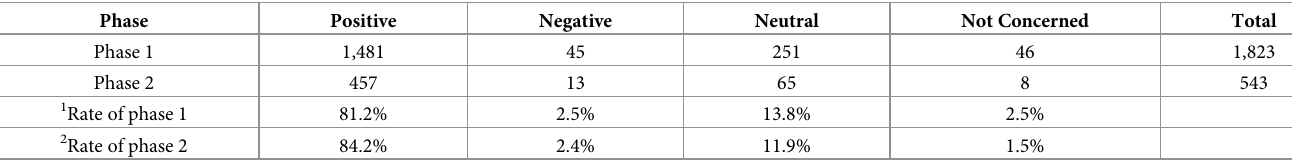
Fig 10. The total number of parameters and average of parameters for each influencer in two phases of the campaign. https://doi.org/10.1371/journal.pone.0274596.g010 Table 6. Analysis the sentiment of comments in each phase of the